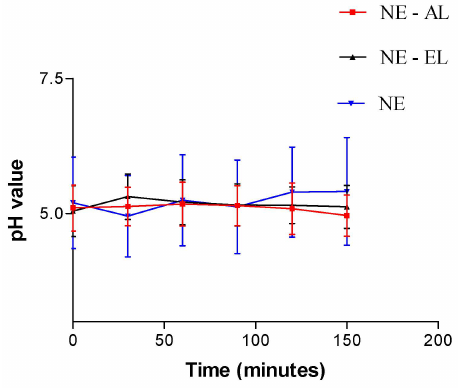
Figure 13. Skin pH values in function of time after nanoemulsion